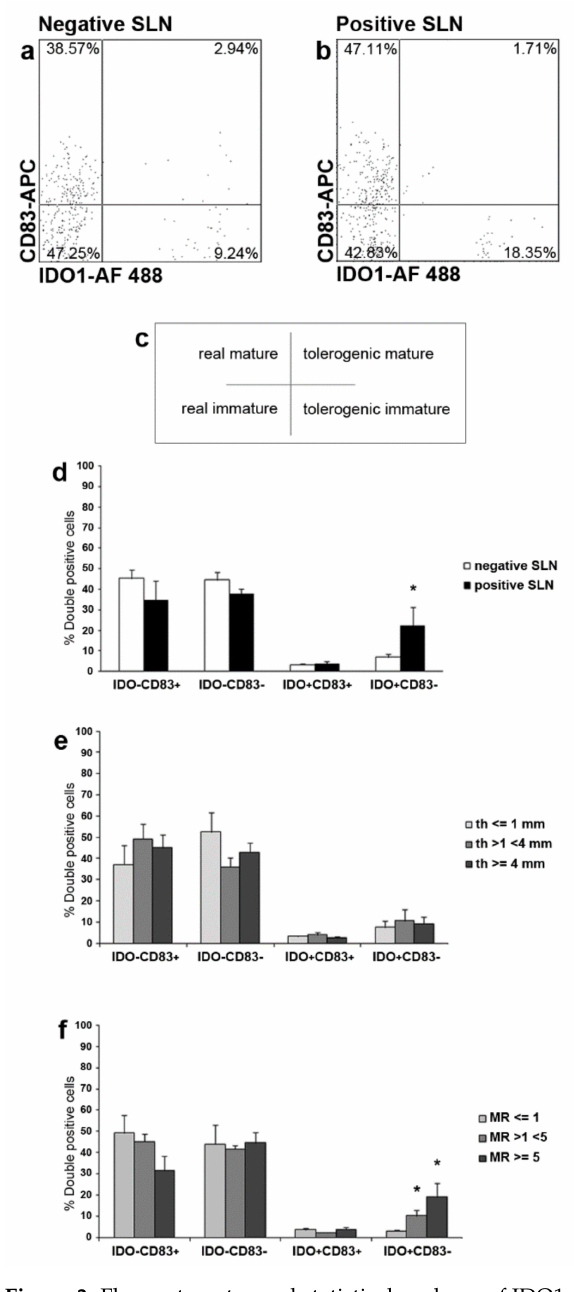
Figure 3. Flow cytometry and statistical analyses of IDO1 and CD83 simultaneous expression in SLN LCs from melanoma patients: identification of four subsets. ( a – f ) Three-color flow cytometry analyses were performed to investigate the concurrent expression of IDO1 and CD83 in SLN LCs from